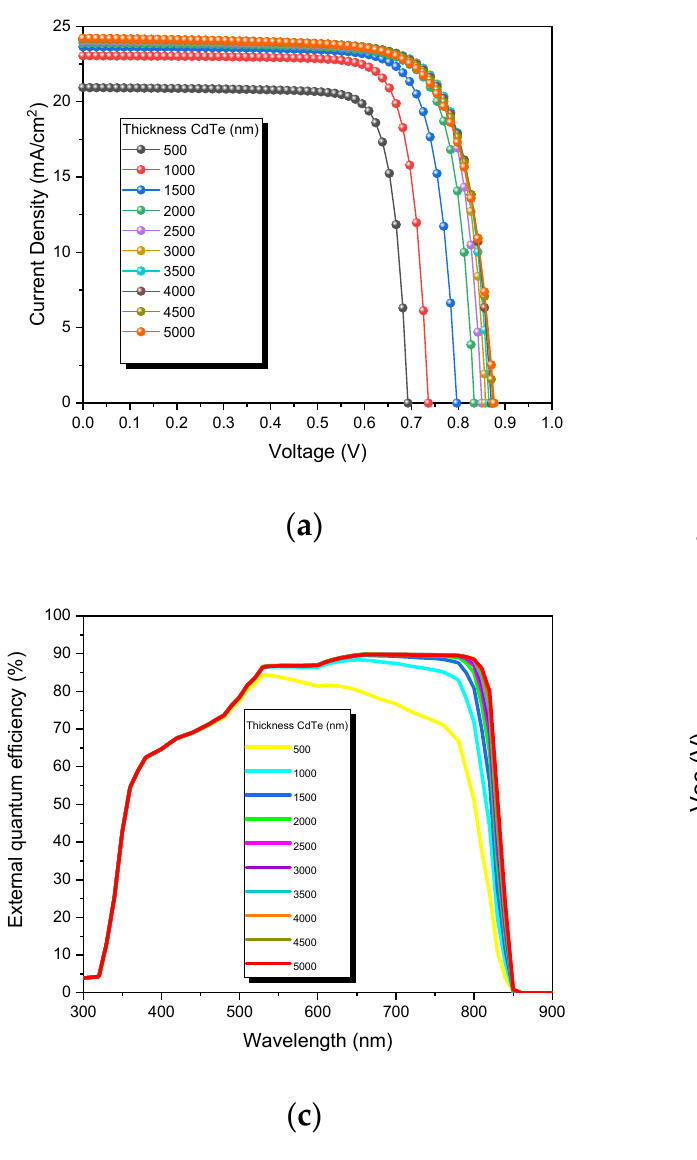
Figure 3. CdTe solar cells at different absorber thicknesses: ( a ) J-V curves, ( b ) output parameters, and ( c ) external quantum